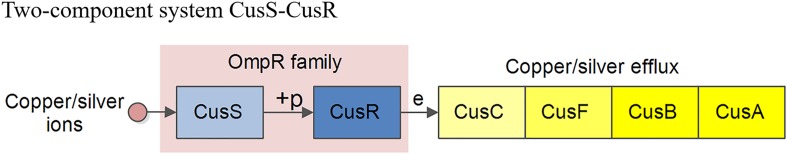
KEGG pathway of the CusS-CusR TCS.